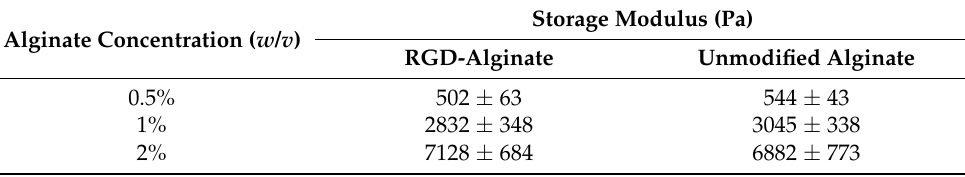
Table 1. Modulus of alginate hydrogels characterized using rotational